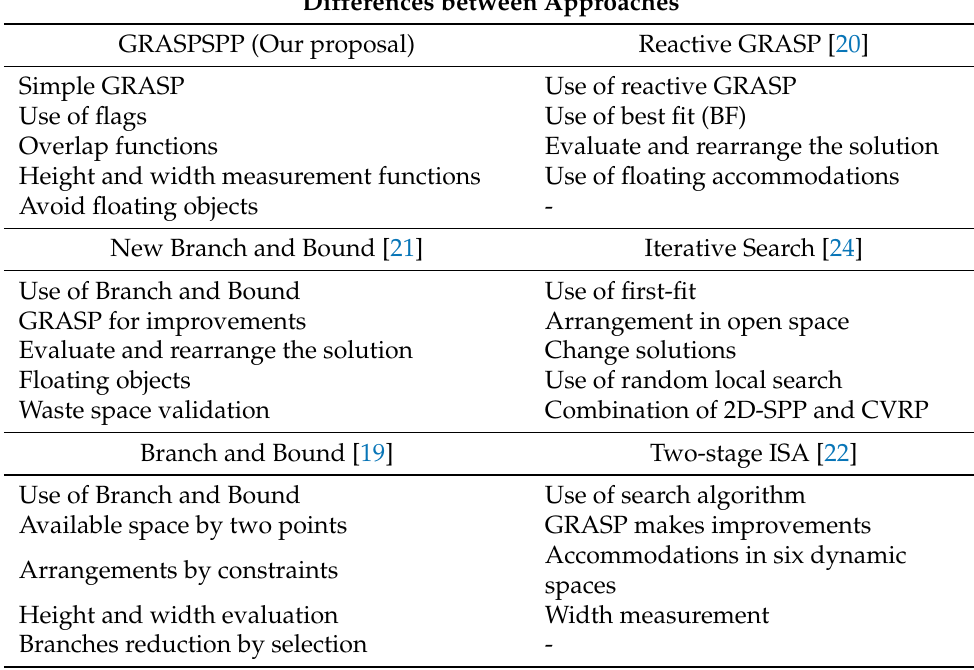
Table 1. Differences between